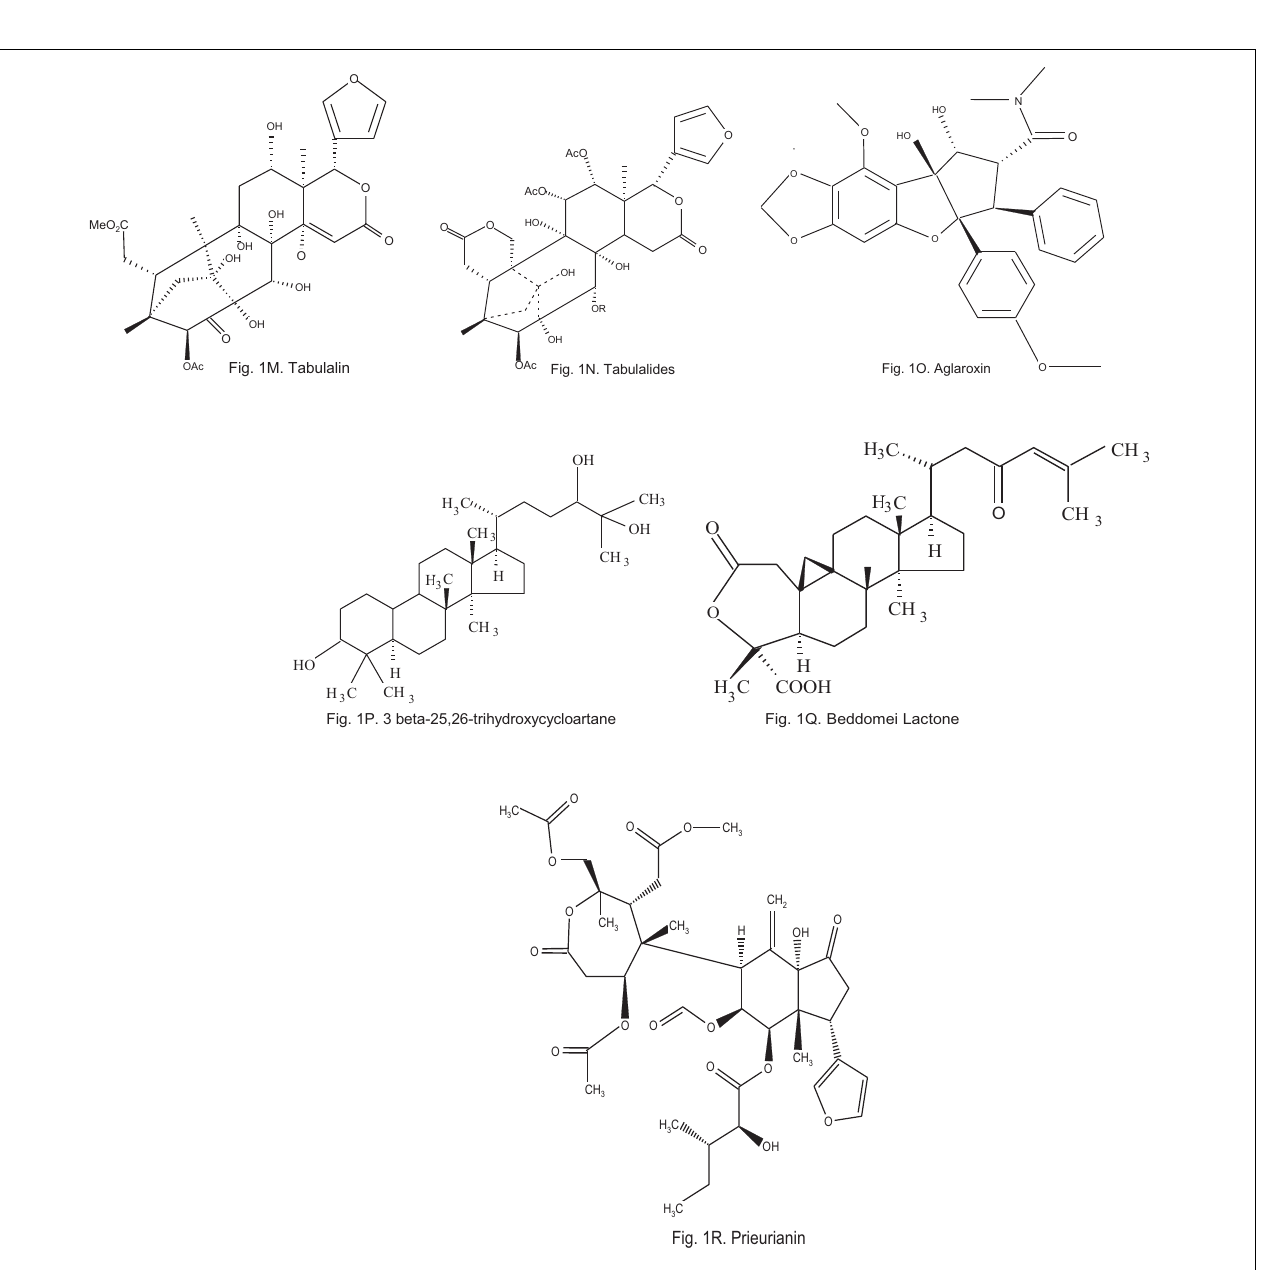
FIGURE 1 | Chemical structure of secondary metabolites identified from Meliaceae